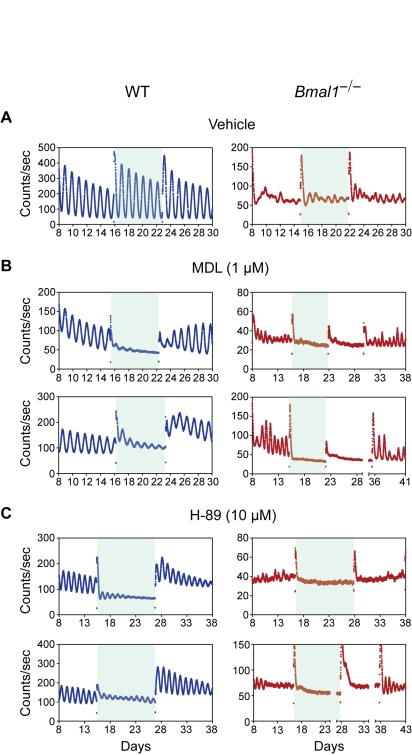
Inhibition of cAMP signaling abolishes stochastic rhythms from Bmal1
−/− SCN explants.(A–C) Representative records of PER2::LUC rhythms of the SCN explants from WT (blue) and Bmal1
−/− (red) mice. Data are shown following a medium change (day 8); shaded area indicates when SCN explants were chronically treated with vehicle solution (A), 1 µM MDL (B), or 10 µM H-89 (C). WT SCN explants recovered rhythms immediately following the washout of MDL (B, left) or H-89 (C, left); however, almost all Bmal1
−/− explants required second washout to reinitiate their rhythms (B and C; right).